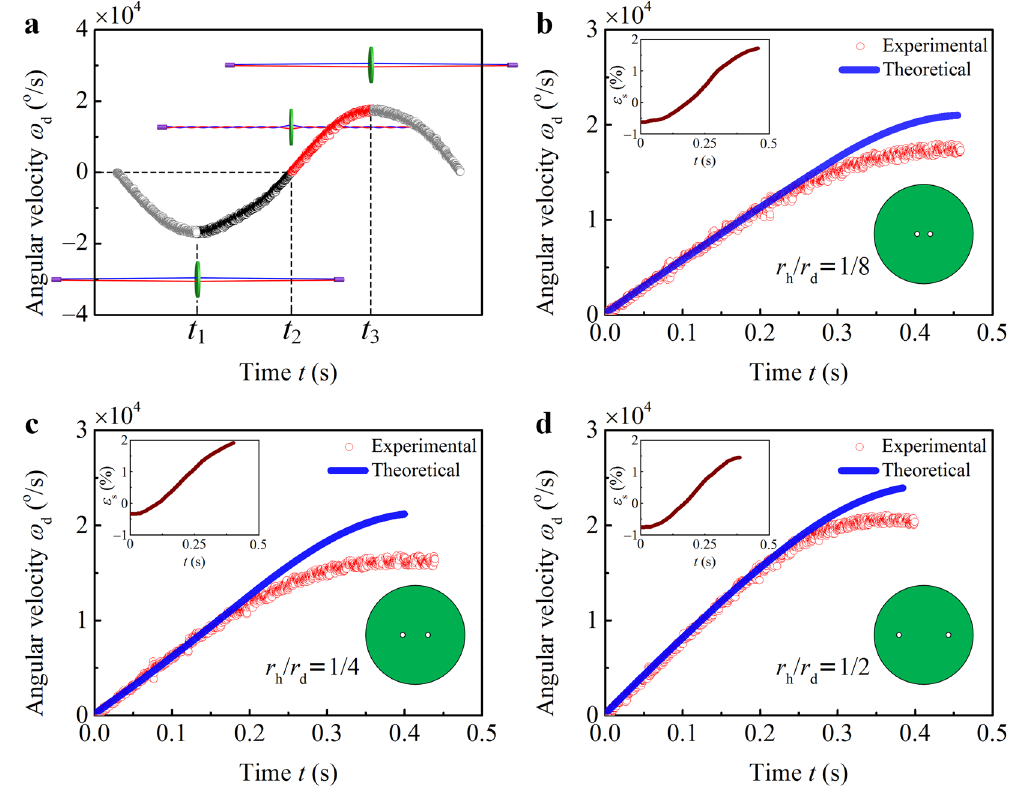
Figure 5. Temporal evolution of the angular velocity of the disk. ( a ) The angular velocity ω d of the disk was measured. The threads were wound from t 1 to t 2 , and unwound from t 2 to t 3 . Both the experimental measurements (red circles) and theoretical predictions (blue lines) of the ω d vs. t relations are plotted, where r h / r d = 1/8 in ( b ), 1/4 in ( c ), and 1/2 in ( d ). The loading history ε s ( t ) was measured and given in the insert of each